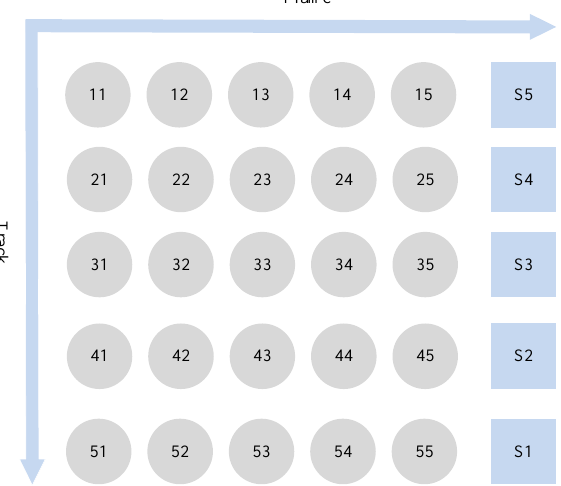
Figure 3. Cylinder array combined output matrix